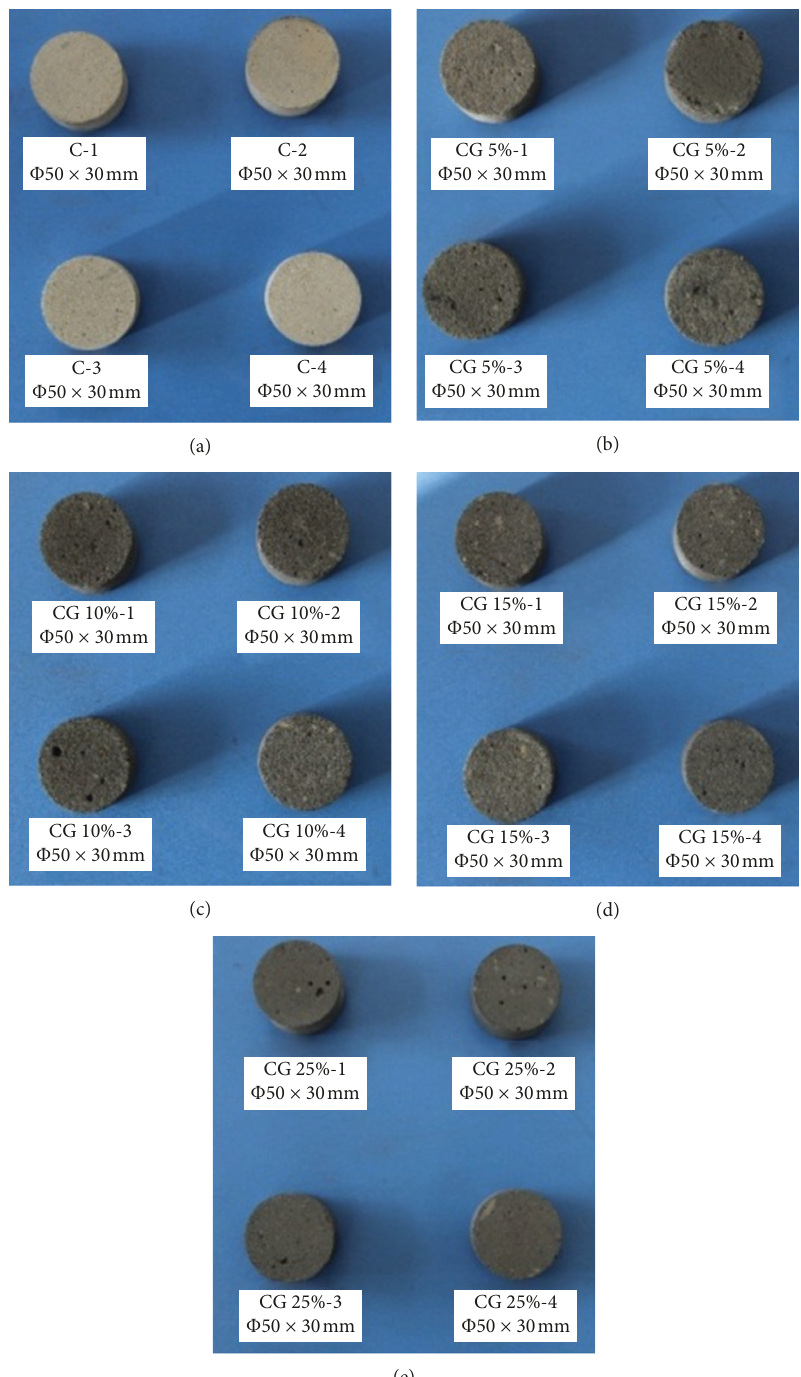
Figure 4: Concrete specimens with different graphite contents. (a) 0%. (b) 5%. (c) 10%. (d) 15%. (e)